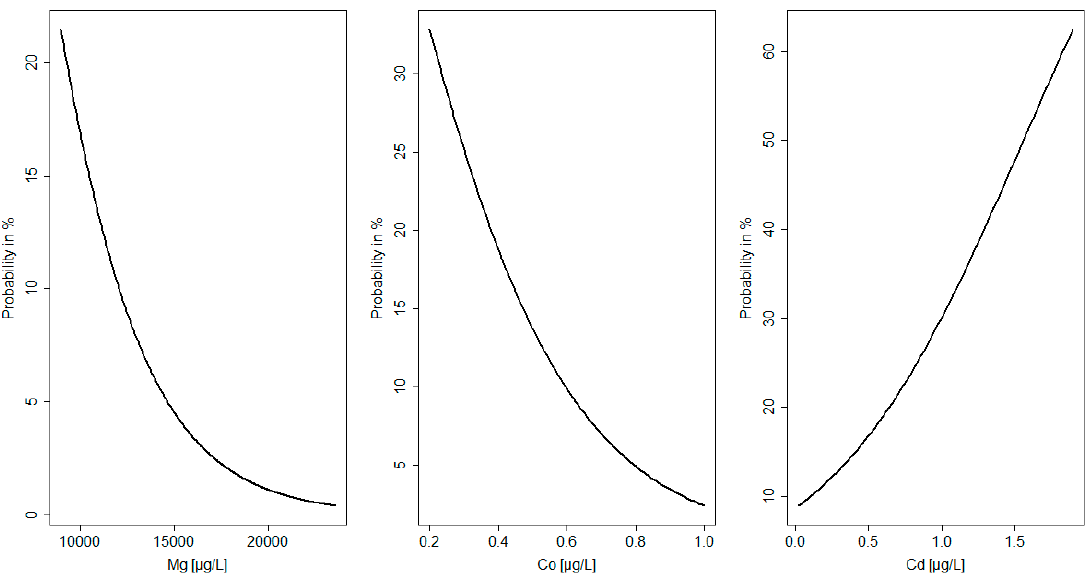
Figure 1. Probability of congenital abnormalities related to element levels in maternal serum.